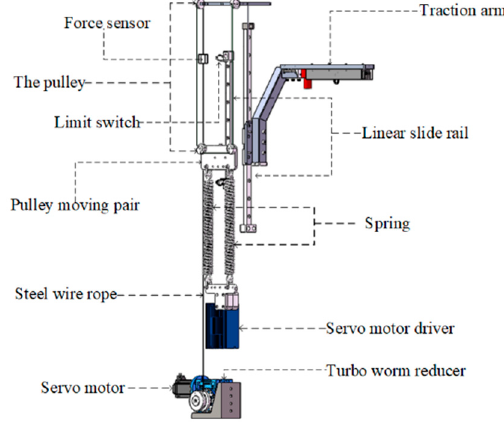
Figure 2. Body weight support system of robot.